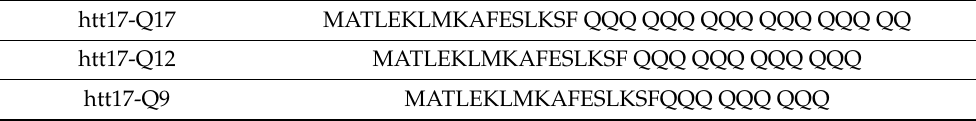
Table 1. Amino acid sequences of huntingtin exon 1-related peptides (UniProt